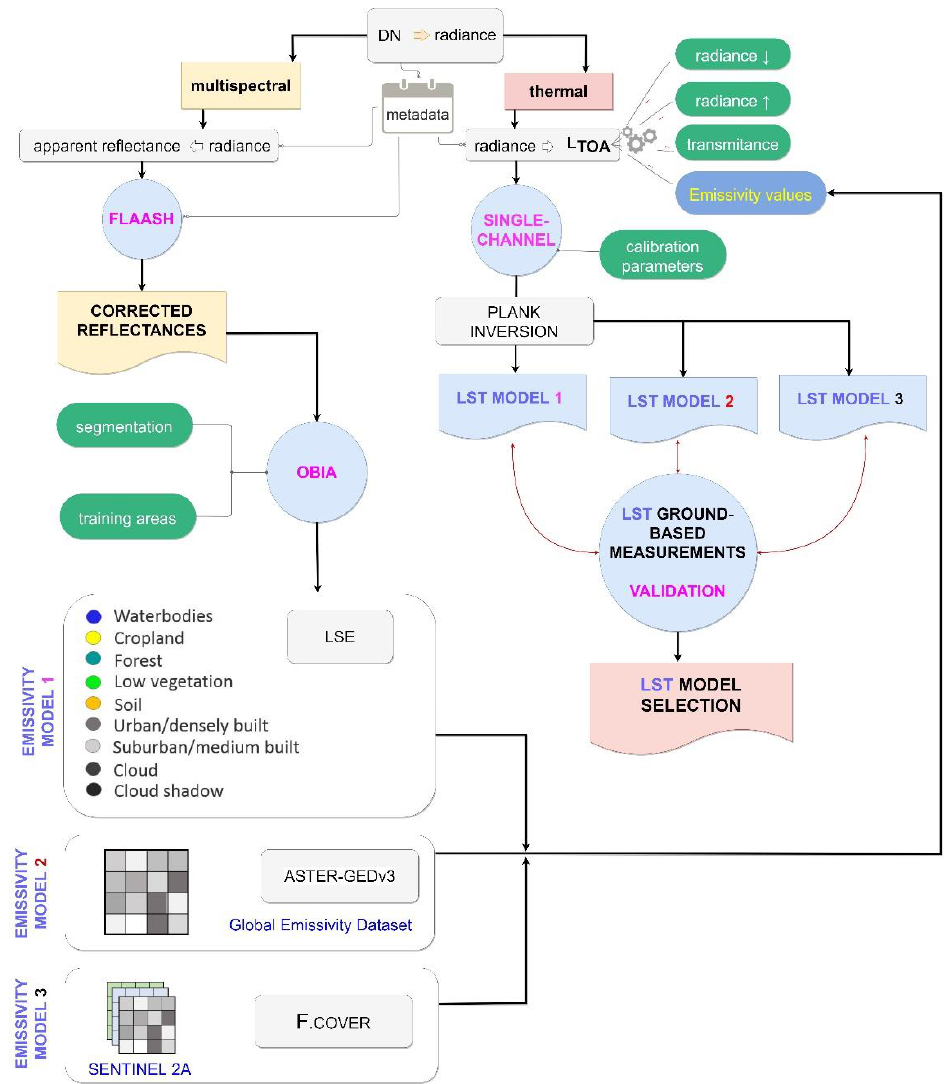
Figure 3. Flowchart for LST estimation and assessment of the emissivity models used in this study. Radiance and transmissivity values are available at https://atmcorr.gsfc.nasa.gov/, accessed on 20 October 2021. The data is a compendium of atmospheric transmissivity values, along with upwelling and downwelling radiances for a given geographical